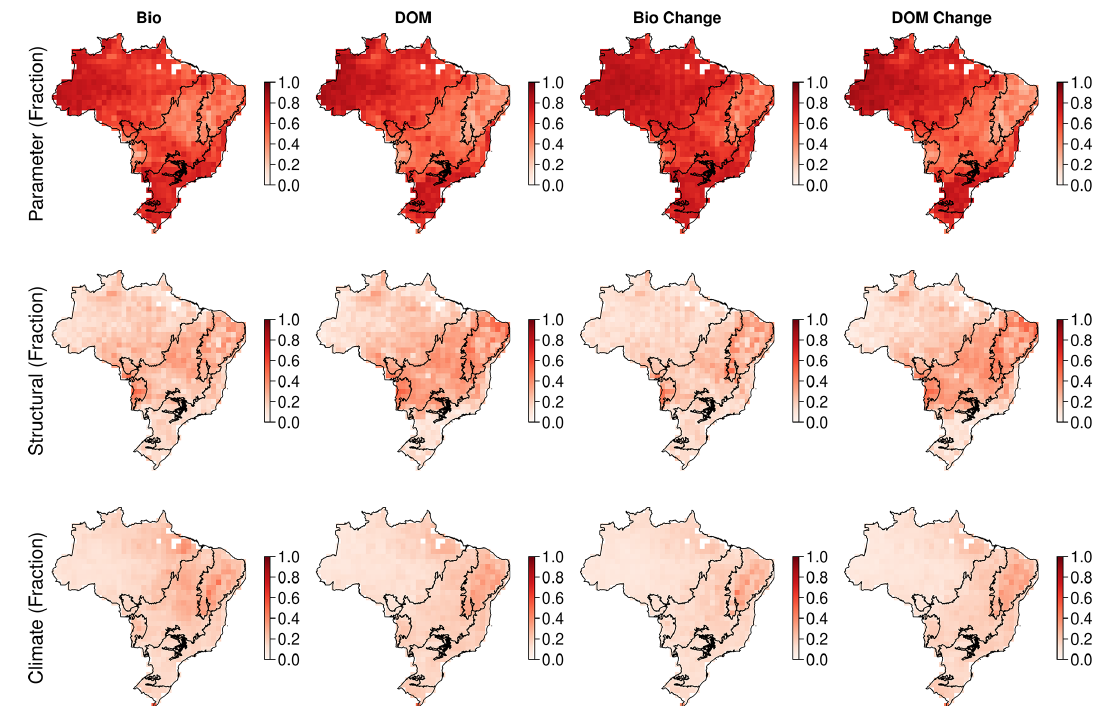
Figure 7. Quantification of the relative contribution of model parameter (top row), structural (middle row) and climate change scenario (lower row) uncertainties on the simulated Brazilian carbon cycle in 2100 at 1 ◦ resolution. Carbon cycle components shown in columns as the live biomass (Bio) and DOM stocks in 2100, and their change between 2017 and 2100. The colour bar indicates the fractional